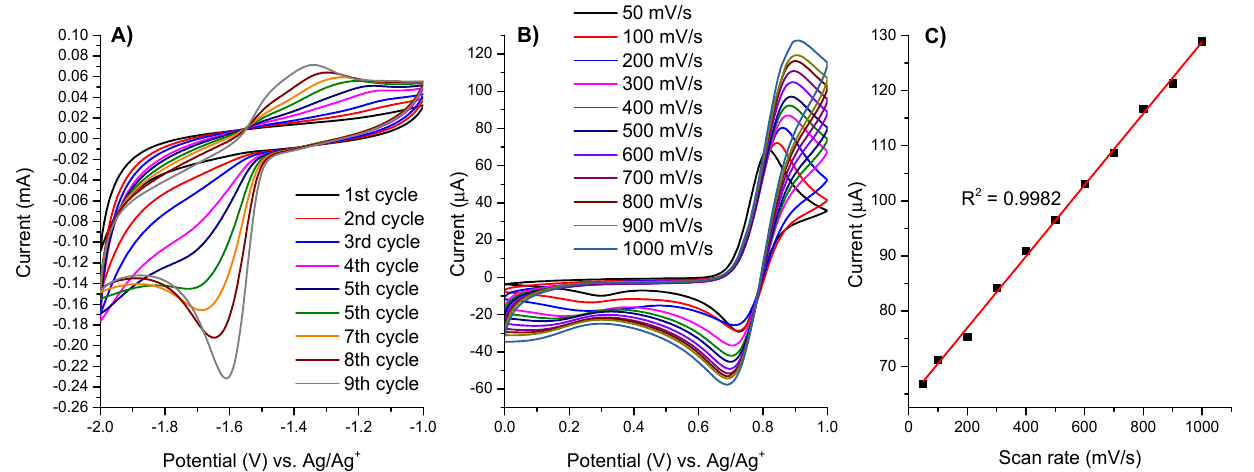
Figure 4. ( A ) Reductive electropolymerization of 1 in 0.1 M solution of TBAClO 4 in deaerated and anhydrous acetonitrile on ITO glass electrode by 10 repeated cyclic potential scans between − 1.0 V and − 2.0 V at scan rate of 100 mV/s; ( B ) CV profiles of the poly-1 film obtained at different scan rates; ( C ) Linear dependence on the scan rates of the anodic peak currents of the poly-1 film.